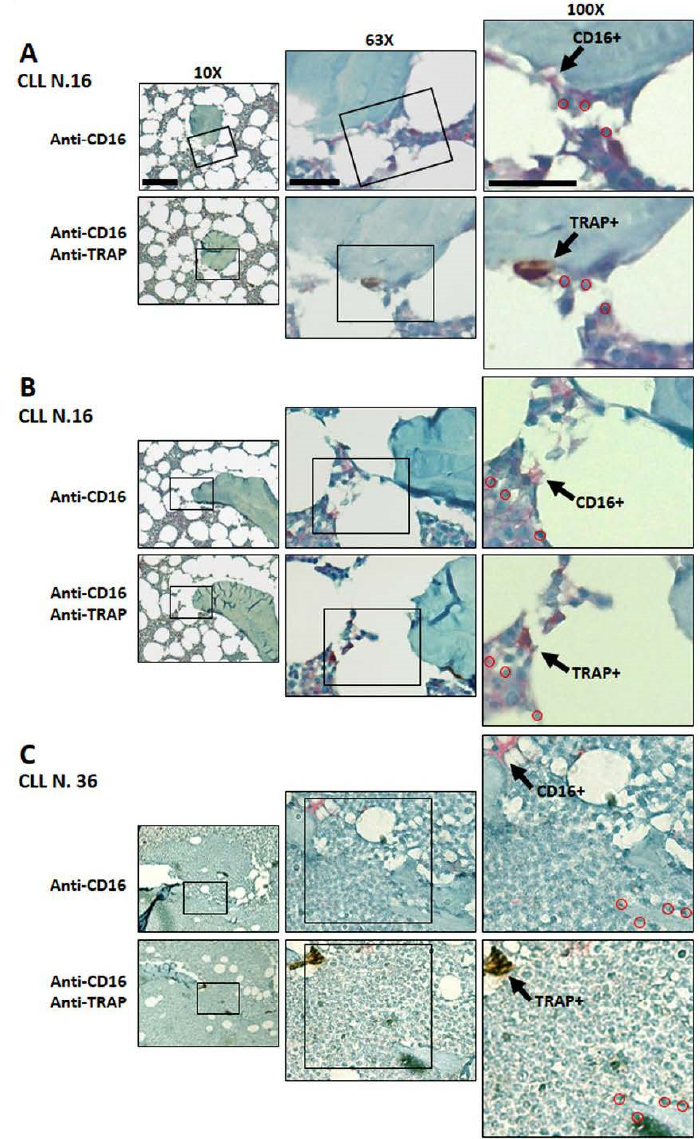
Figure 8. Immunodetection of CD16- and TRAP-positive cells in CLL bone marrow biopsies. ( A – C ) Images display progressive enlargements of serial sections to better evaluate CD16 and TRAP positivity in Monocytes/Osteoclasts present in BM biopsies from two CLL patients (N.16, N.36). Single (CD16) or double (CD16/TRAP) positivity could be evidenced in the same cells (arrows). The red circles, identifying cell nuclei positions, were used as references. Bars correspond to 50 µ m for 10 × images and to 8 µ m for 63 × and 100 × images,